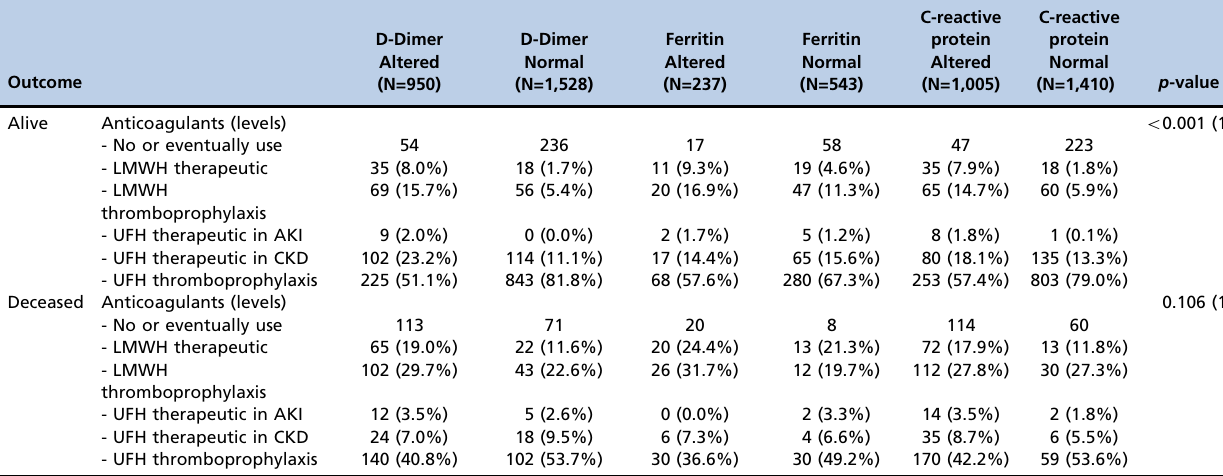
Table 4 - Absolute distribution of 2,478 patients by vital status and levels of anticoagulants.